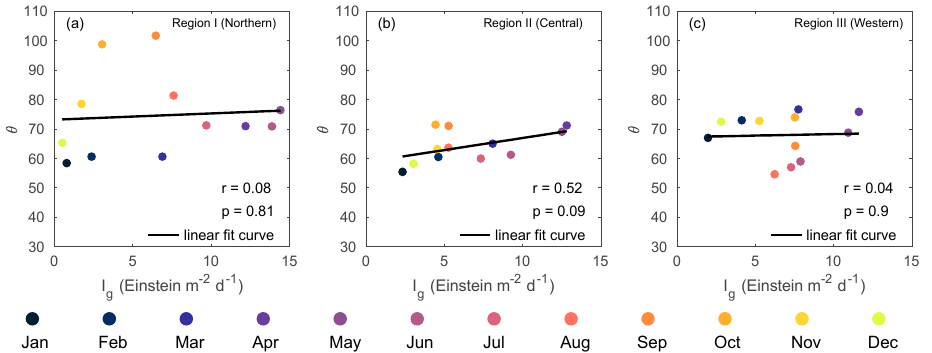
Figure 9. Monthly mean climatology of θ as a function of I g . ( a ) Region I, ( b ) Region II, ( c ) Region III. The solid line represents a linear fit to OC-CCI data.